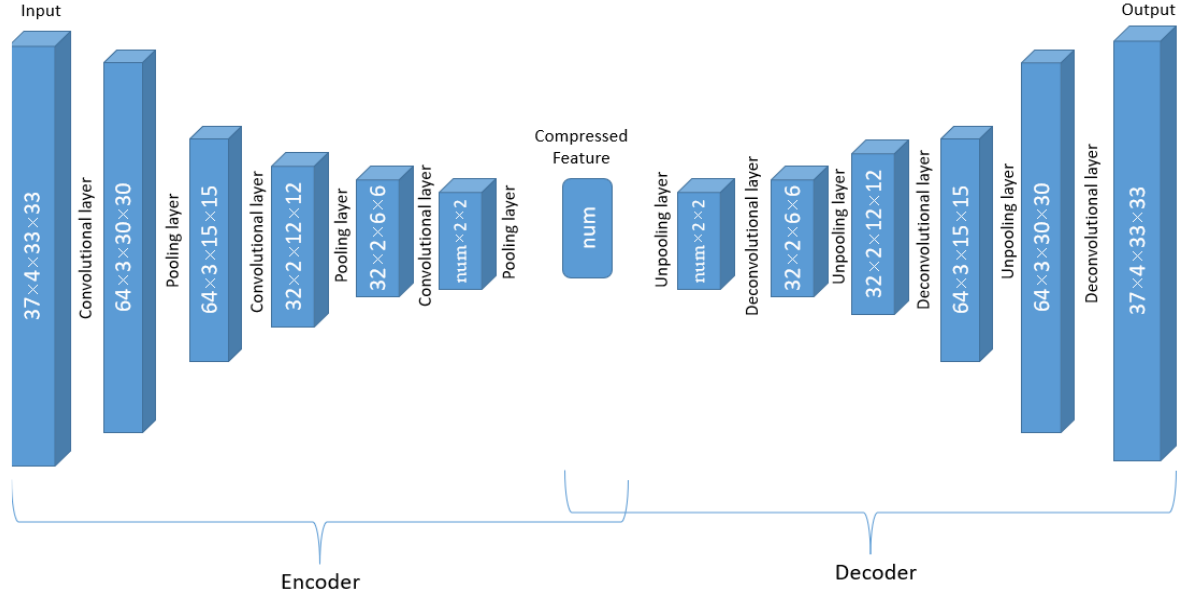
Figure 3. Dimension changes in the ERA data through the 3D CNN auto-encoder layers. The first convolution layer is with 64 different 37 (channel) × 2 × 4 × 4 filters and converts the 37 × 4 × 33 × 33 array for one variable to 64 3 × 30 × 30 arrays. In other words, a 37 × 2 × 4 × 4 filter is applied, and the results are summed up in the channel dimension (37), and therefore the vertical pressure layer dimension number is reduced to 1. This procedure is repeated 64 times with different convolution weights. Therefore, after the first convolution layer, the original 37 × 4 × 33 × 33 array